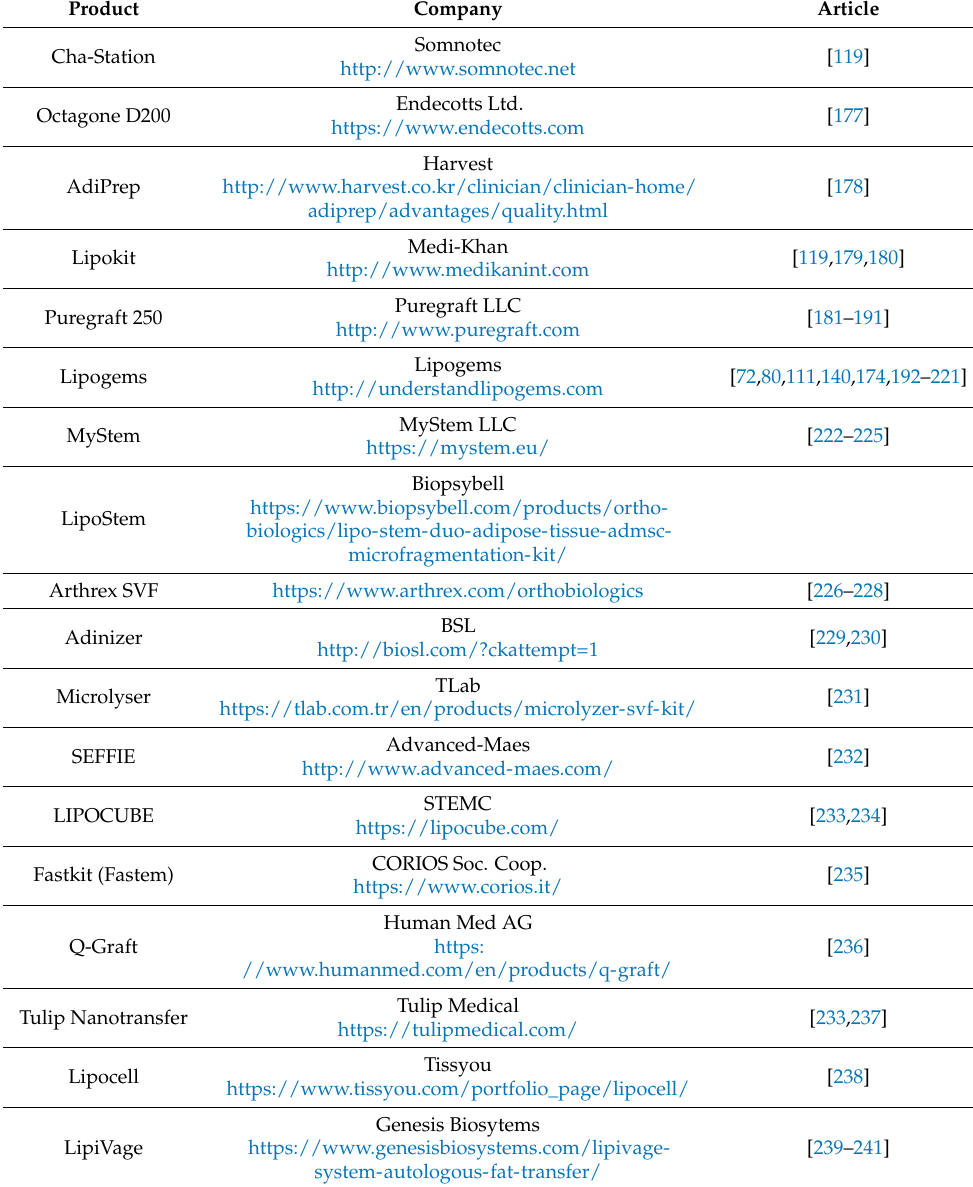
Table 5. Commercial Medical Products for AD-tSVF Preparation (accession date to the web sites was 22 August